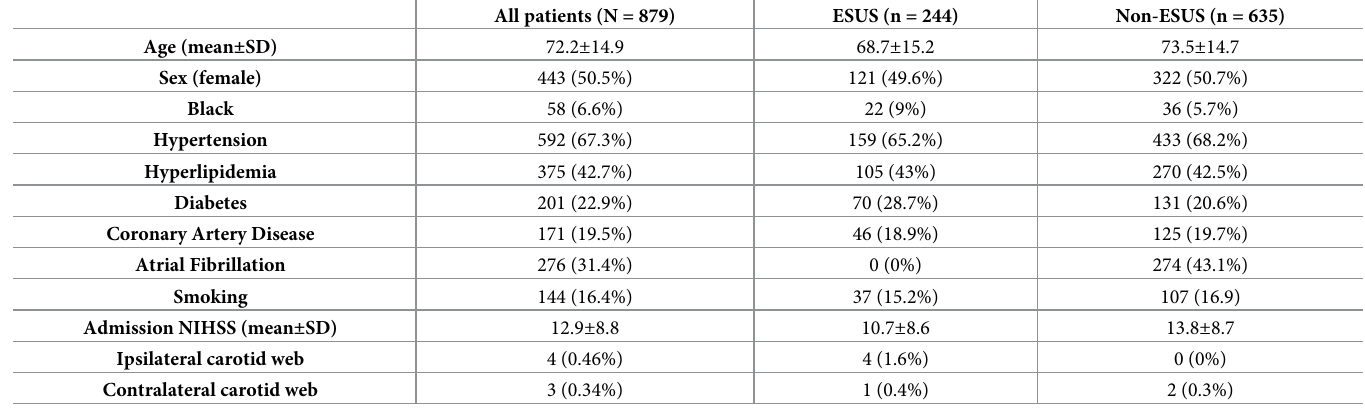
Table 1. Key clinical characteristics of patients in the study